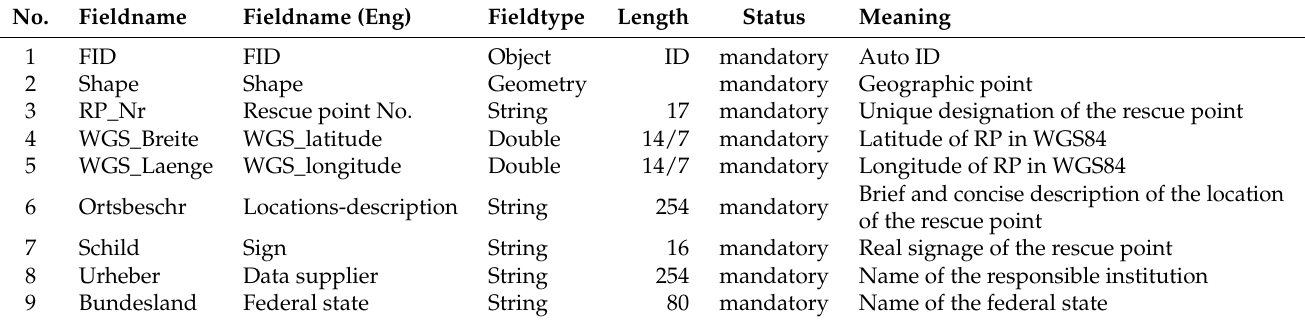
Table 1. Description of the federal level rescue point data model provided by the